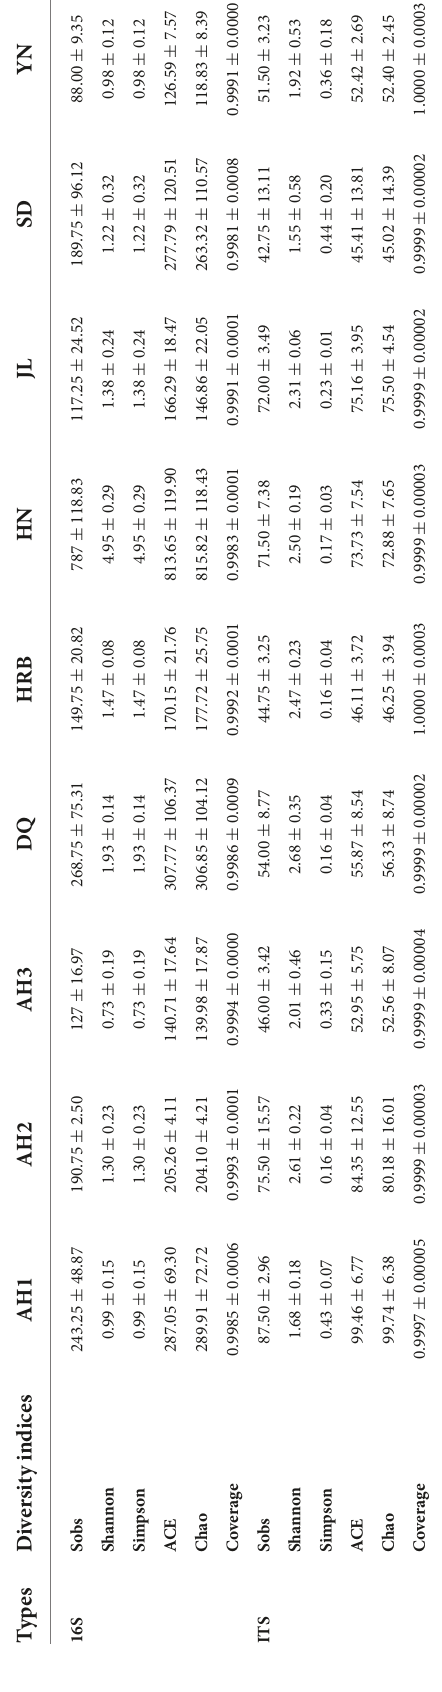
clustered together based on their geographic locations. However, for samples from the northeast (Heilongjiang and Jilin) and eastern China (Shandong), their samples were inter-mixed. For example, three samples each from HRB and DQ were clustered in group B, but the remaining sample from HRB and DQ (one each from these two regions) were clustered with those from other geographic areas ( Figure 4 ). Heatmap analyses showed similar results. Groups A, B, C, D, and E described in the UPGMA graph were similarly found in the heat map. Within groups A, B, and C, the sample distances at the OTU